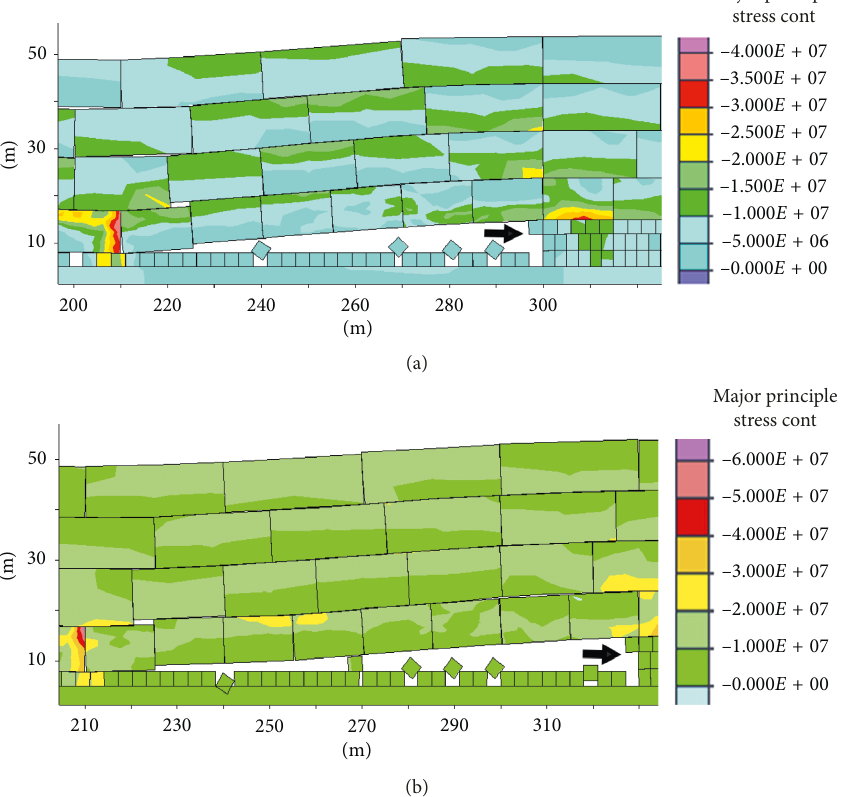
Figure 10: Evolution process of the rotative pressure-arch structure of multiple key blocks. (a) Rotative pressure-arch structure. (b) Sinking of the pressure-arch of the basic